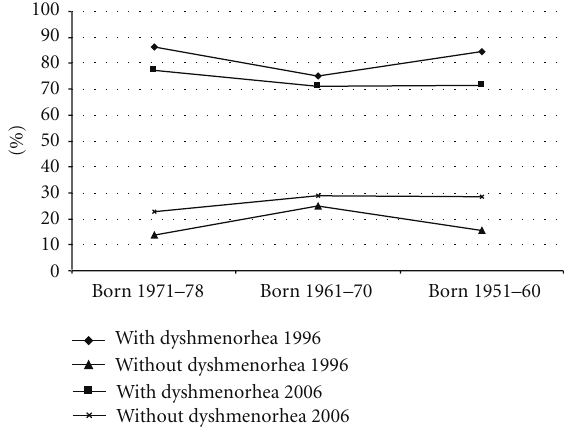
Figure 7: Birth cohort e ff ect on the prevalence (%) in 10